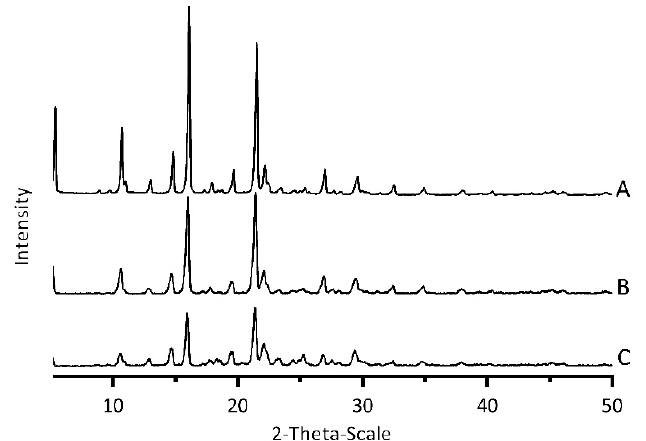
Figure 6. Powder X-ray di ff raction (PXRD) patterns of ( A ) CLX crude powder, ( B ) PM and ( C ) optimized CLX-NC.